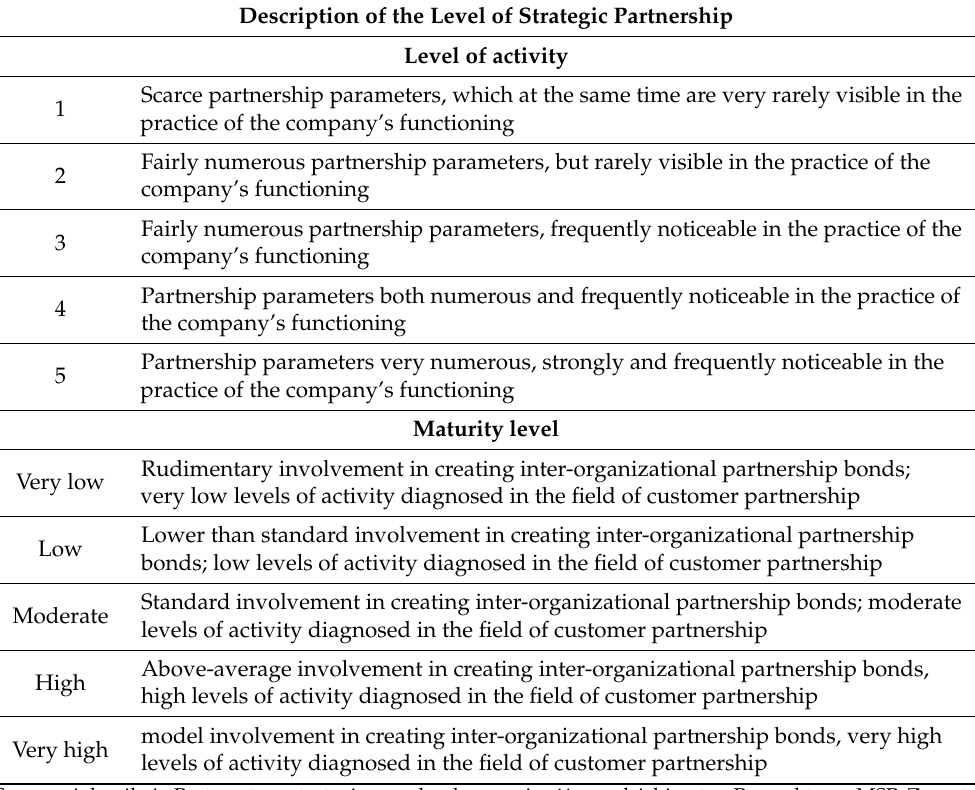
Table 1. Levels of activity and maturity of strategic partnership proposed for the purpose of evalua- tion of the areas of customer